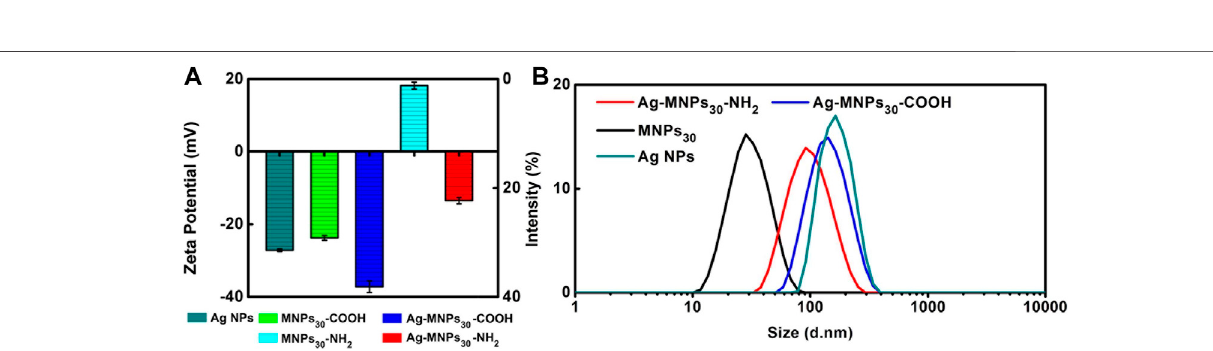
FIGURE 3 | (A) The process of detecting AFP and the direction of the pressure valve at each step. (B) Different NMR signals in the dispersed state and the aggregated state.